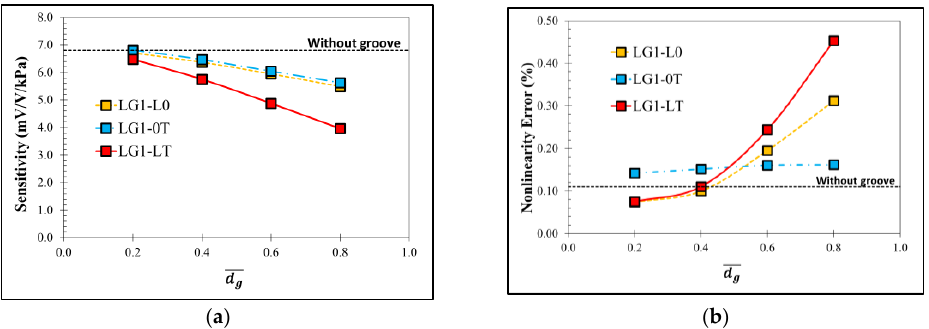
Figure 7. Stress difference distributions at the longitudinal piezoresistor without groove and with local groove 𝐿𝐺1 − 𝐿𝑇 ( 𝑑 𝑔 ̅̅̅ = 0.8) at the applied pressure of 5 kPa. (Only one-half of the domain is displayed.)